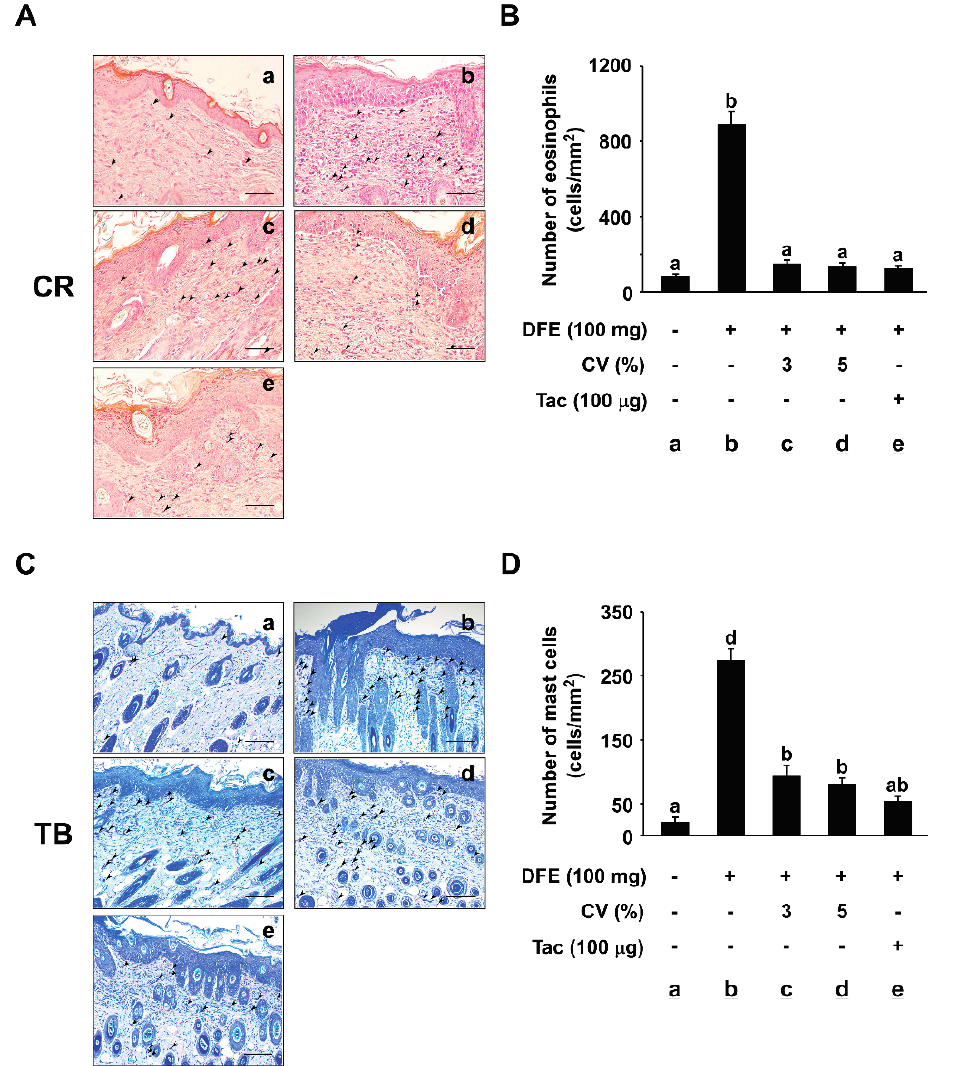
Figure 3. Effect of CV on DFE-induced eosinophil and mast cell infiltration into skin lesions. ( A ) Representative images depicting the histological features of skin lesions are shown. Skin lesions were stained with Congo red (CR) to identify eosinophils. The arrows indicate the CR-stained eosinophils. Eosinophils were counted under a microscope at 400× magnification. Scale bar, 50 μ m; ( B ) The numbers of eosinophils in 1 mm 2 sections of skin lesion were measured and graphed. Data represent the mean values ± SEM ( n = 6). Mean values with letters (a–b) within a graph are significantly different from each other at p < 0.05; ( C ) Representative images depicting the histological features of skin lesions. Skin lesions were stained with toluidine blue (TB) to identify mast cells. The arrows indicate the TB-stained mast cells. Mast cells were counted under a microscope at 400× magnification. Scale bar, 50 μ m; and ( D ) The numbers of mast cells in 1 mm 2 sections of skin lesion were measured and graphed. Data represent the mean values ± SEM ( n = 6). Mean values with letters (a, b, d) within a graph are significantly different from each other at p <